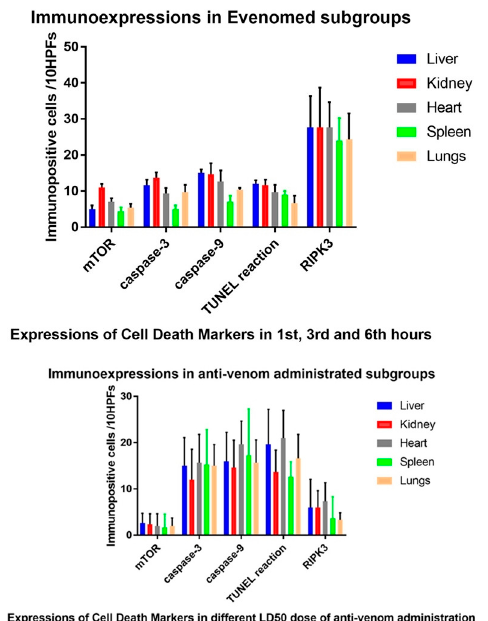
Figure 2. Immunoexpressions of mTOR, caspases, DNA in situ fragmentation and RIPK3 in experimental groups according to mean calculation of time elapsing and anti-venom